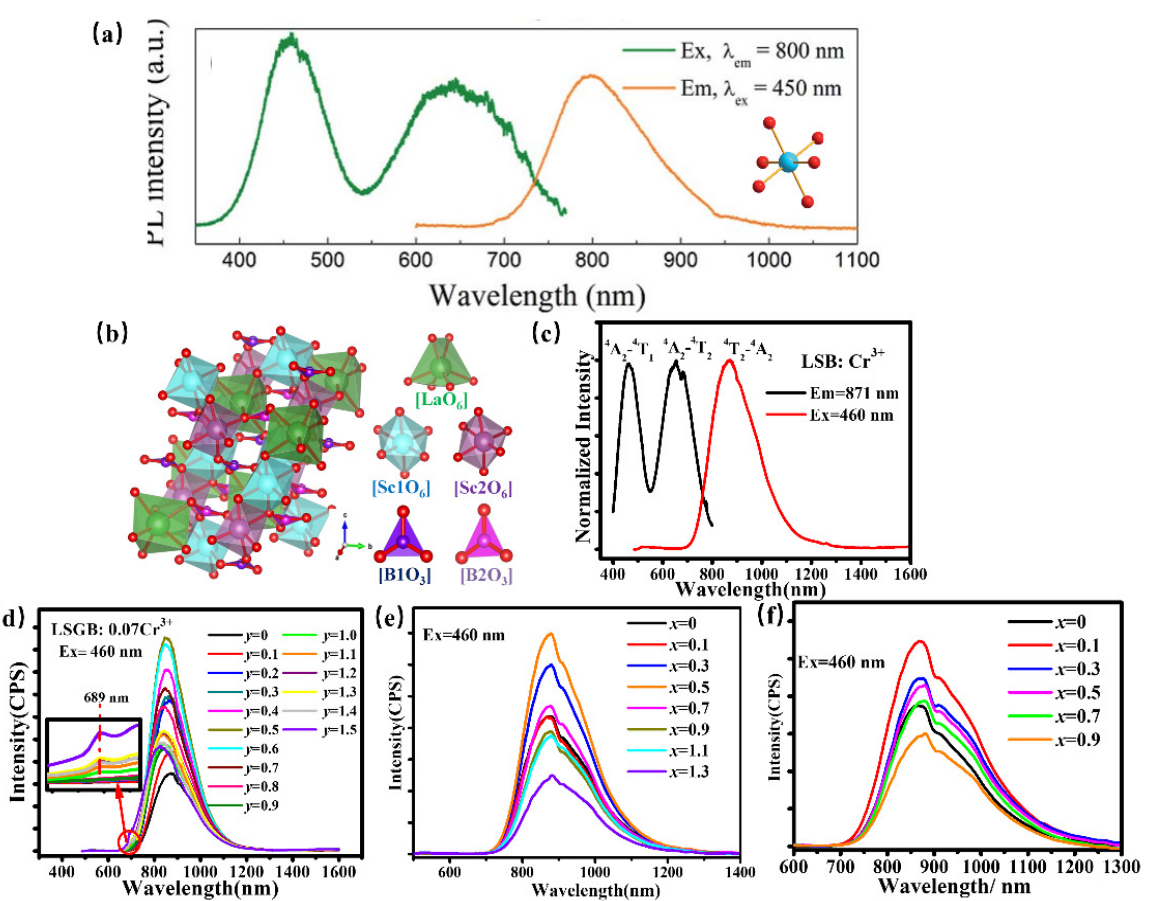
Figure 16. ( a ) PLE and PL spectra of ScBO 3 : Cr 3+ and the coordination environment of [ScO6] octahedron (Ex = 450 nm and Em = 800 nm) [80]. ( b ) The crystal structure of LaSc 3 B 4 O 12 ( c ) PLE and PL spectra of LaSc 3 B 4 O 12 : Cr 3+ (Ex = 460 nm and Em = 871 nm). ( d ) PL spectra of LaSc 2.93 − y Ga y B 4 O 12 : 0.07Cr 3+ (0 ≤ y ≤ 1.5) (The inset showing the variation at 689 nm) (Ex = 460 nm) ( e ) PL spectra of LaSc 2.93 − x Y x B 4 O 12 : 0.07Cr 3+ (0 ≤ x ≤ 1.3) (Ex = 460 nm). ( f ) PL spectra of LaSc 3 − 2 x Ca x Si x B 4 O 12 (LSCSB): Cr 3+ (0 ≤ x ≤ 1.0) (Ex = 460 nm).